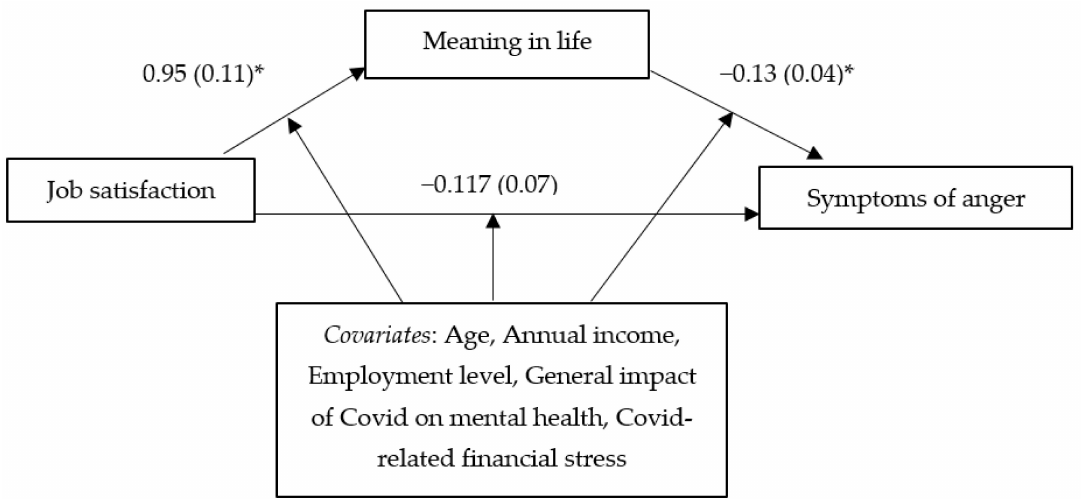
Figure 2. Mediation relationship between job satisfaction, meaning in life, and symptoms of anger. * p <